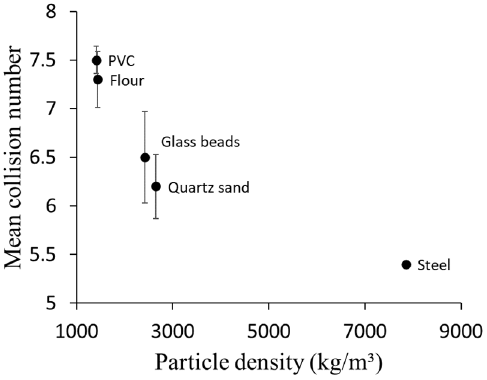
Figure 5. Comparing mean collision numbers of 100-micron particles with different densities. All particles assumed spherical particles released into a 1 m pipe with 4.76 mm inner diameter, and the air velocity was 8.4 (m/s).